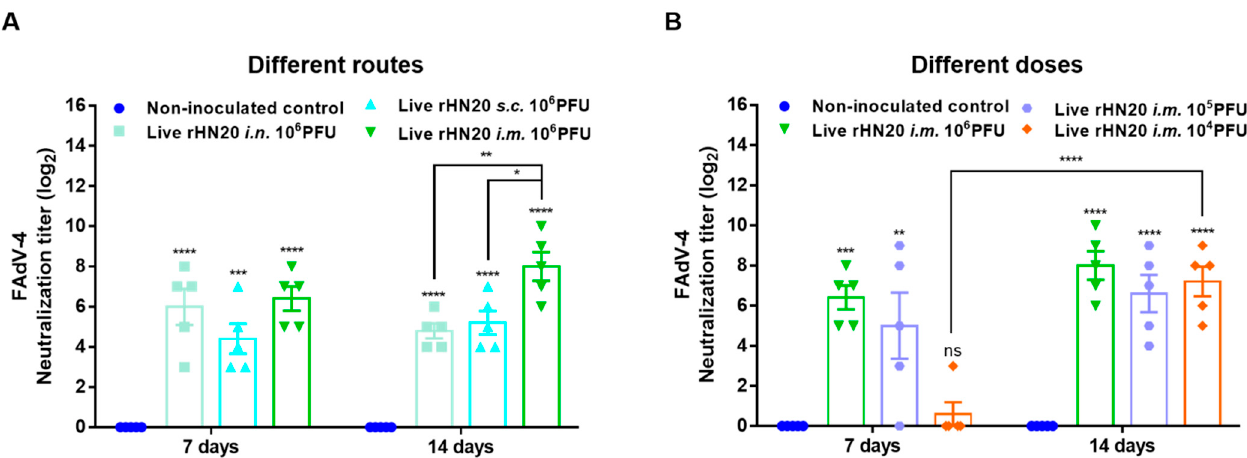
Figure 2. Neutralizing activity of vaccinated chicken serum towards FAdV-4. The neutralizing activity of immune serum after administration via different routes ( A ) and different doses ( B ) in chickens was detected using FAdV-4 strain rWT- EGFP in LMH cells at 7 and 14 days post-immunization. The data for the non-inoculated control group and i.m. 10 6 PFU group are shown in ( A , B ) are shared. Error bars represent the SEM. The significance of differences was determined using two-way analysis of variance, with *, p < 0.05, **, p < 0.01, ***, p < 0.001, ****, p < 0.0001, and ns, not significant. Routes for immunization were: i.n. = intranasal, s.c. = subcutaneous, and i.m. =